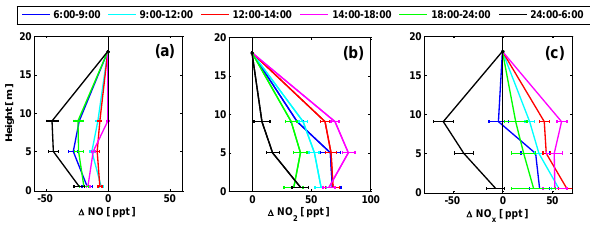
Figure 6. Vertical gradients of NO, NO 2 , and NO x . Dot and whiskers represent means and standard errors of the mixing ratio enhancement at each height. The colors represent the enhancement at 6 different times of day through the complete diurnal cycle: early morning